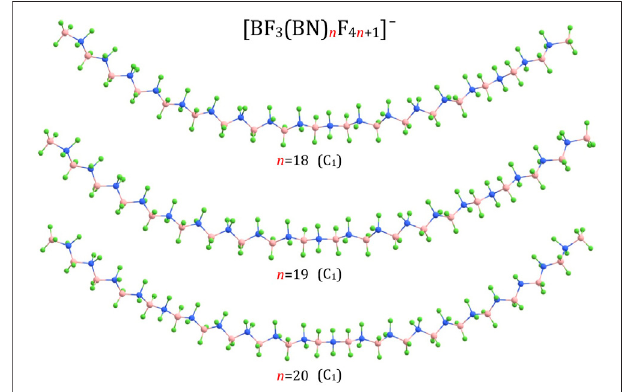
FIGURE5| Equilibriumstructuresof(BF 3 (BN) n F 4 n +1 ) – ( n =18 – 20)anions (symmetry point group in